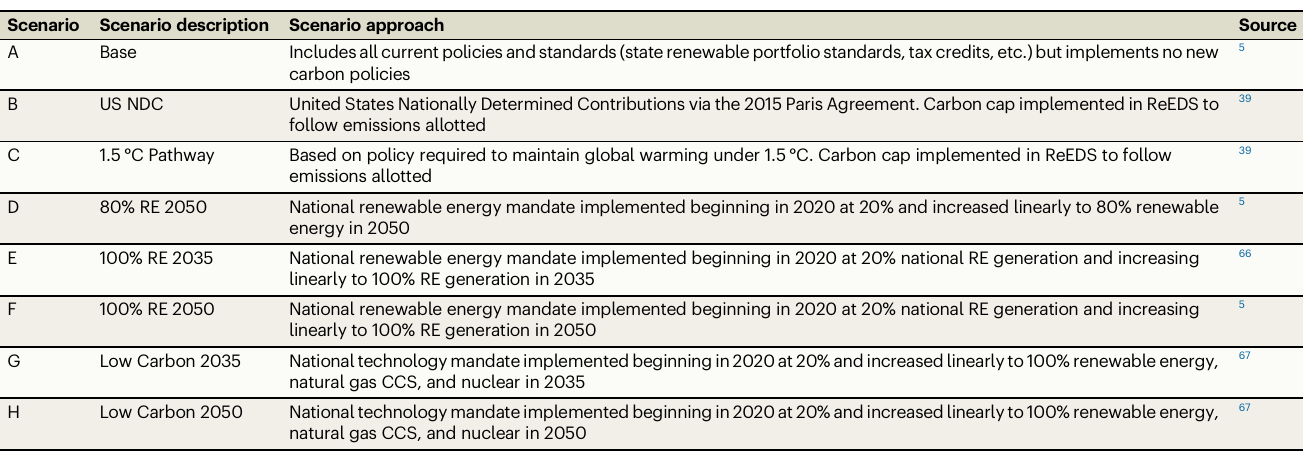
Table 1 | Description of decarbonization scenarios and their implemented policies in ReEDS (see SI Table S-1 for a description of ReEDS carbon policy inputs for each scenario) Scenario Scenario description Scenario